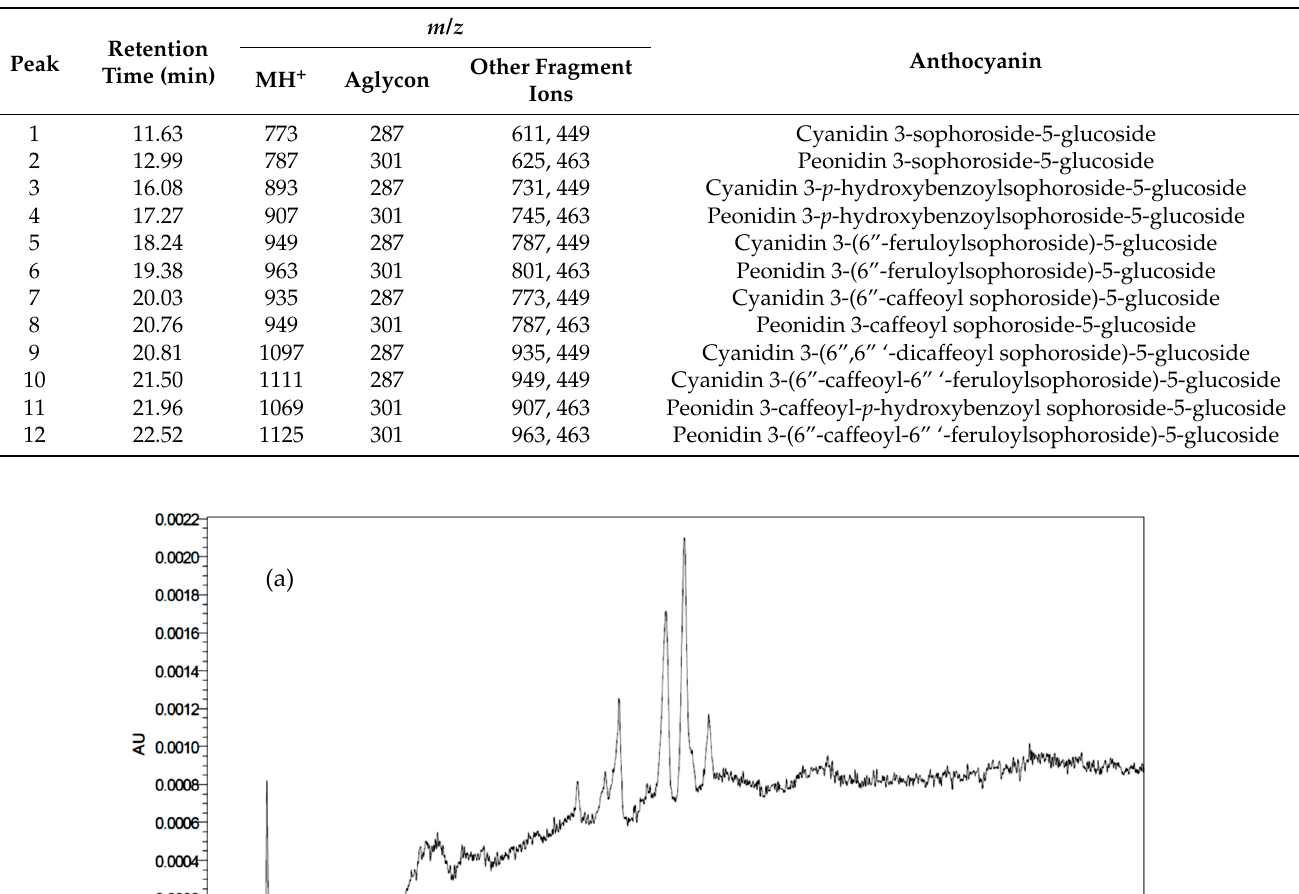
Table 6. Identification of PSPP anthocyanins by mass spectrometry.